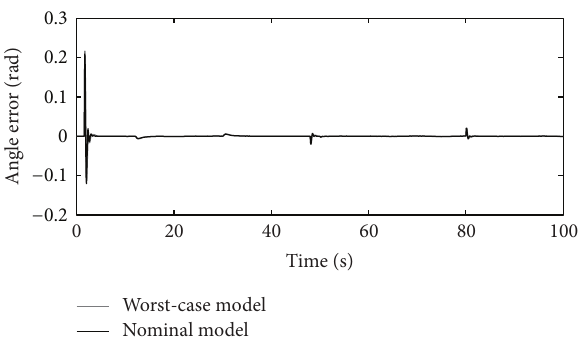
Figure 16: Output of the controller 𝐶(𝑠) with disturbance attenua- tion.